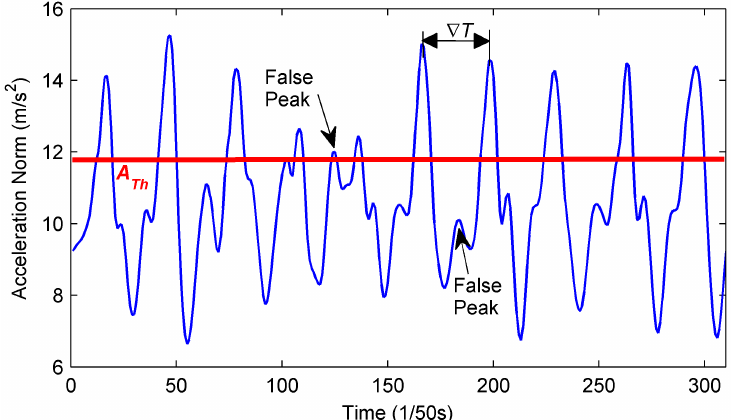
Figure 2. Peak detection based on periodic patterns of the acceleration